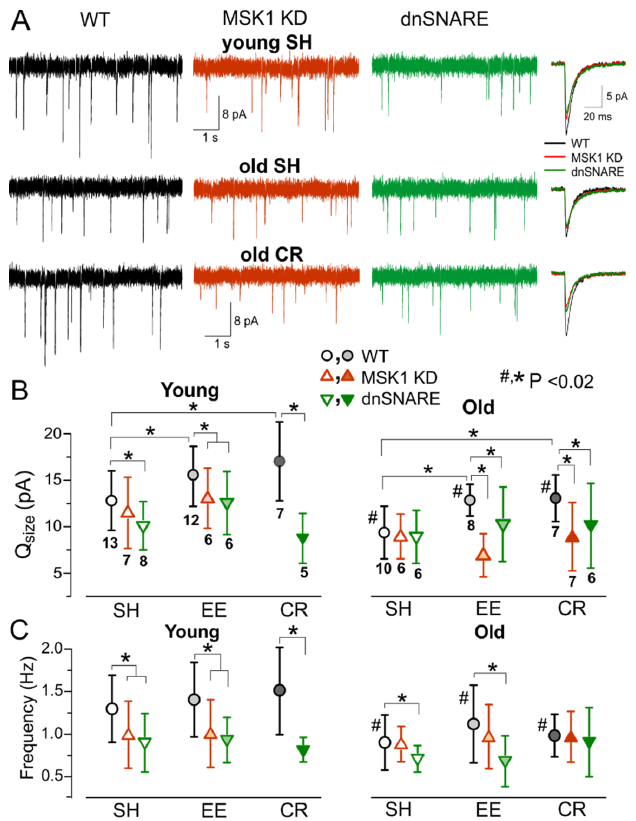
Figure 4. The experience-related alterations in the excitatory synaptic transmission. The AMPA receptor-mediated miniature spontaneous synaptic currents (mEPSCs) were recorded in the neocortical layer 2/3 pyramidal neurons at − 80 mV in presence of 100 µM picrotoxin, 1 µM TTX and 10 µM PPADS. ( A ) representative whole-cell currents recorded in neurons of young (top row) and old SH (middle row) and EE (bottom row) WT, MSK1 KD, and dnSNARE mice (left, middle, and right columns, respectively). The inserts on the right shows average mEPSCs waveforms. Note the significant decrease in the mEPSC amplitude in the old WT mice of standard housing and up-regulation of mEPSCs in the EE mice. The effect of EE is impaired in the MSK1 KD and dnSNARE mice. ( B , C ) Pooled data on the quantal size ( B ) and frequency ( C ) of mEPSCs in the mice of different age and experience groups. Data are shown as mean ± SD for the number of neurons indicated in ( B ). The statistical significance (2-population unpaired t -test) for the difference between young and old mice of same genotype and experience is indicated by (#) symbols; asterisks (*) indicate statistically significance of the difference between different genotype and experience groups as indicated. In stark contrast to the WT mice, mEPSCs recorded in the neurons of MSK1 KD mice underwent the age-related decline but did not exhibit significant EE- or CR-induced increase in the average amplitude or quantal size (Figure 4A,B) supporting the importance of MSK1 for the homeostatic plasticity. The mEPSCs recorded in the dnSNARE mice exhibited only modest EE- and CR-induced increase in the average mEPSCs amplitude. The difference in the quantal size of mEPSCs between WT and dnSNARE mice was statistically significant only for the EE-exposed animals of younger age